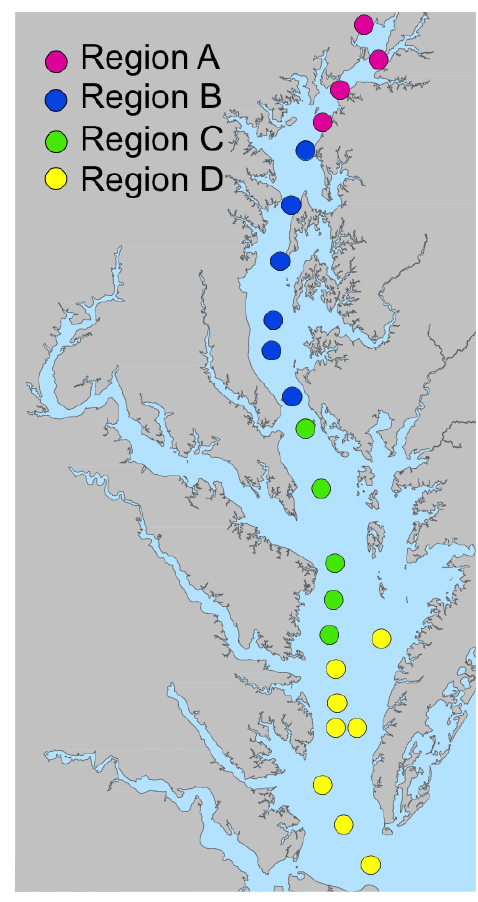
Figure 1. Map of the Chesapeake Bay with water quality moni- toring stations (Table A1) identified by region, based primarily on salinity. A: oligohaline; B and C: upper and lower mesohaline; D: